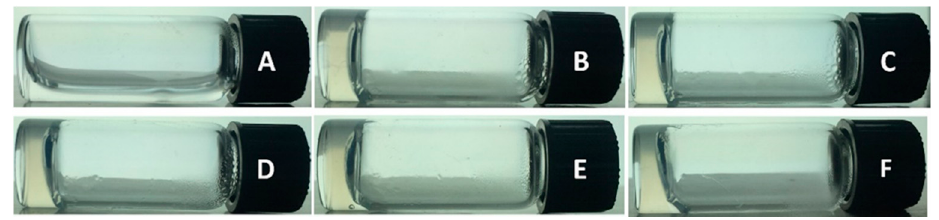
Figure 3. Optical images of 0.4 wt% NapFFKKFKLKL ( 2 ) ( A ) without or with the addition of ( B ) 0.5, ( C ) 1, ( D ) 2, ( E ) 3 and ( F ) 4 equiv. (molar ratio) AcDALDLTD ( 3 ) after 24 h.